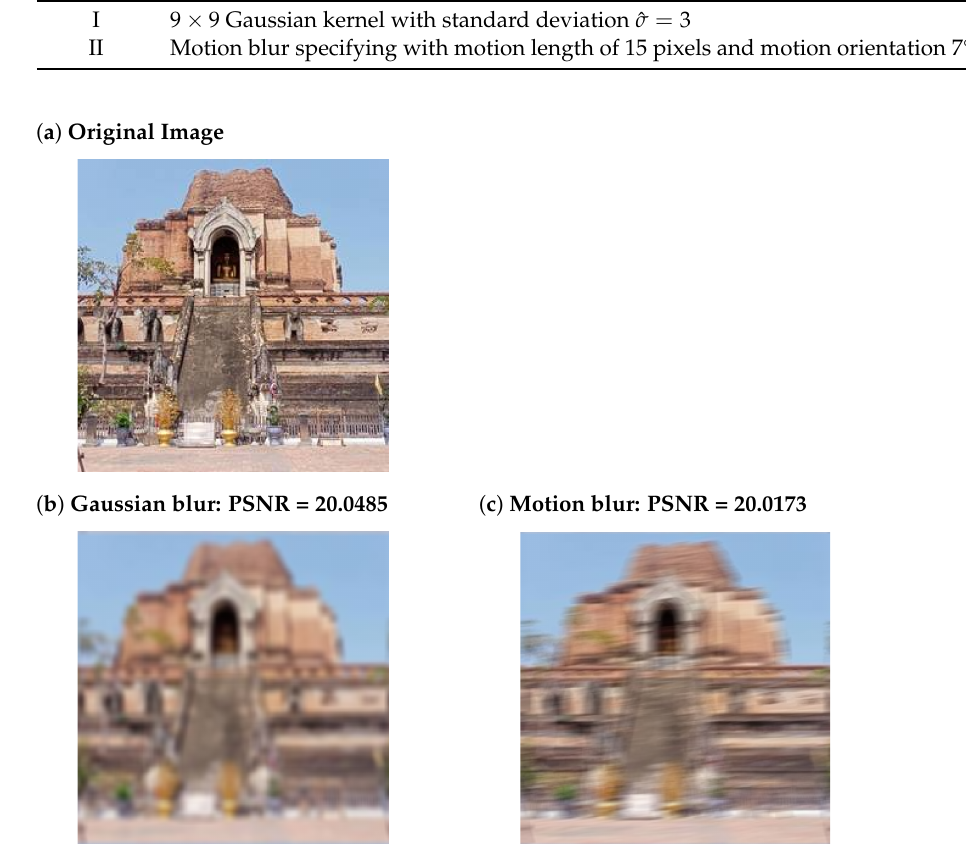
Figure 2. The test images. ( a ) original image, ( b ) Blurred image in scenario I, and ( c ) Blurred image in scenario